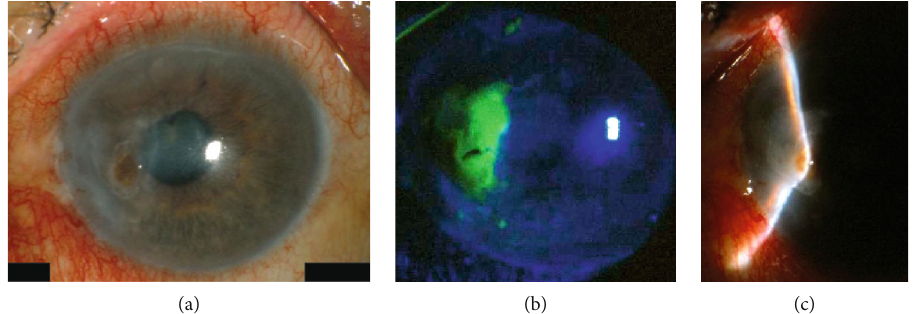
Figure 2: Slit-lamp photographs of the patient ’ s left eye at his initial visit. Slit-lamp examination revealed corneal perforation (a). Corneal epithelial defects were seen using fl uorescein staining (b). The space in his left anterior chamber had almost disappeared (c).